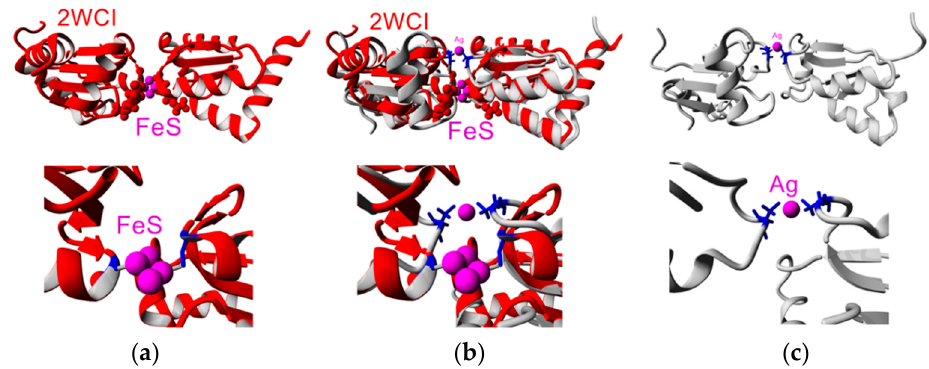
Figure 8. Comparison of global structure of dimeric GRX and their active sites. ( a ) The Fe-S GRX from E. coli (PDB: 2WCI); ( b ) overlay with Fe-S GRX from E. coli (PDB: 2WCI) (red) with silver metalated GRX (gray); ( c ) the model of the silver metalated dimer structure; 16C is shown in blue.